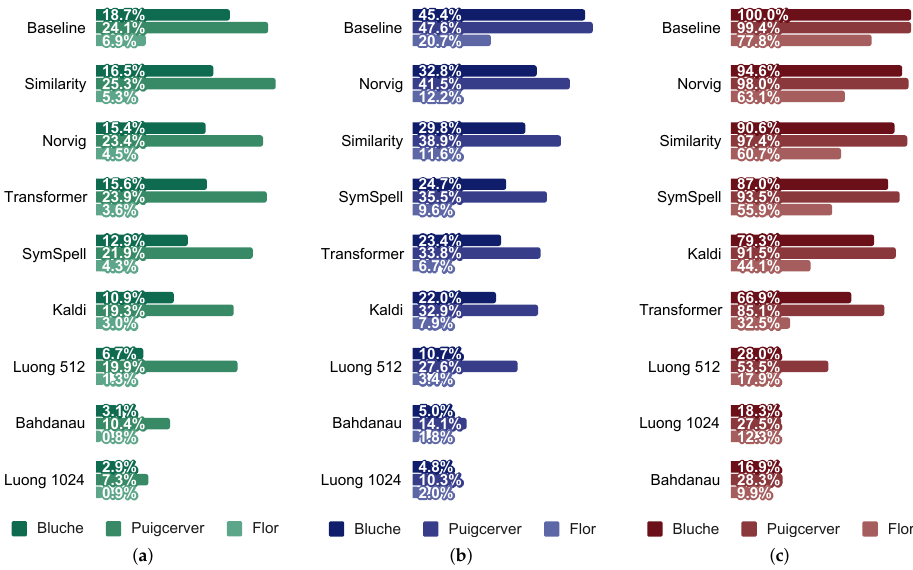
Figure 20. Error rates in the Washington dataset (lower is better), ( a ) Character Error Rate (CER); ( b ) Word Error Rate (WER); ( c ) Sequence Error Rate